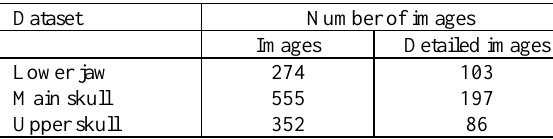
Table 2. Total number of images for data acquisition.